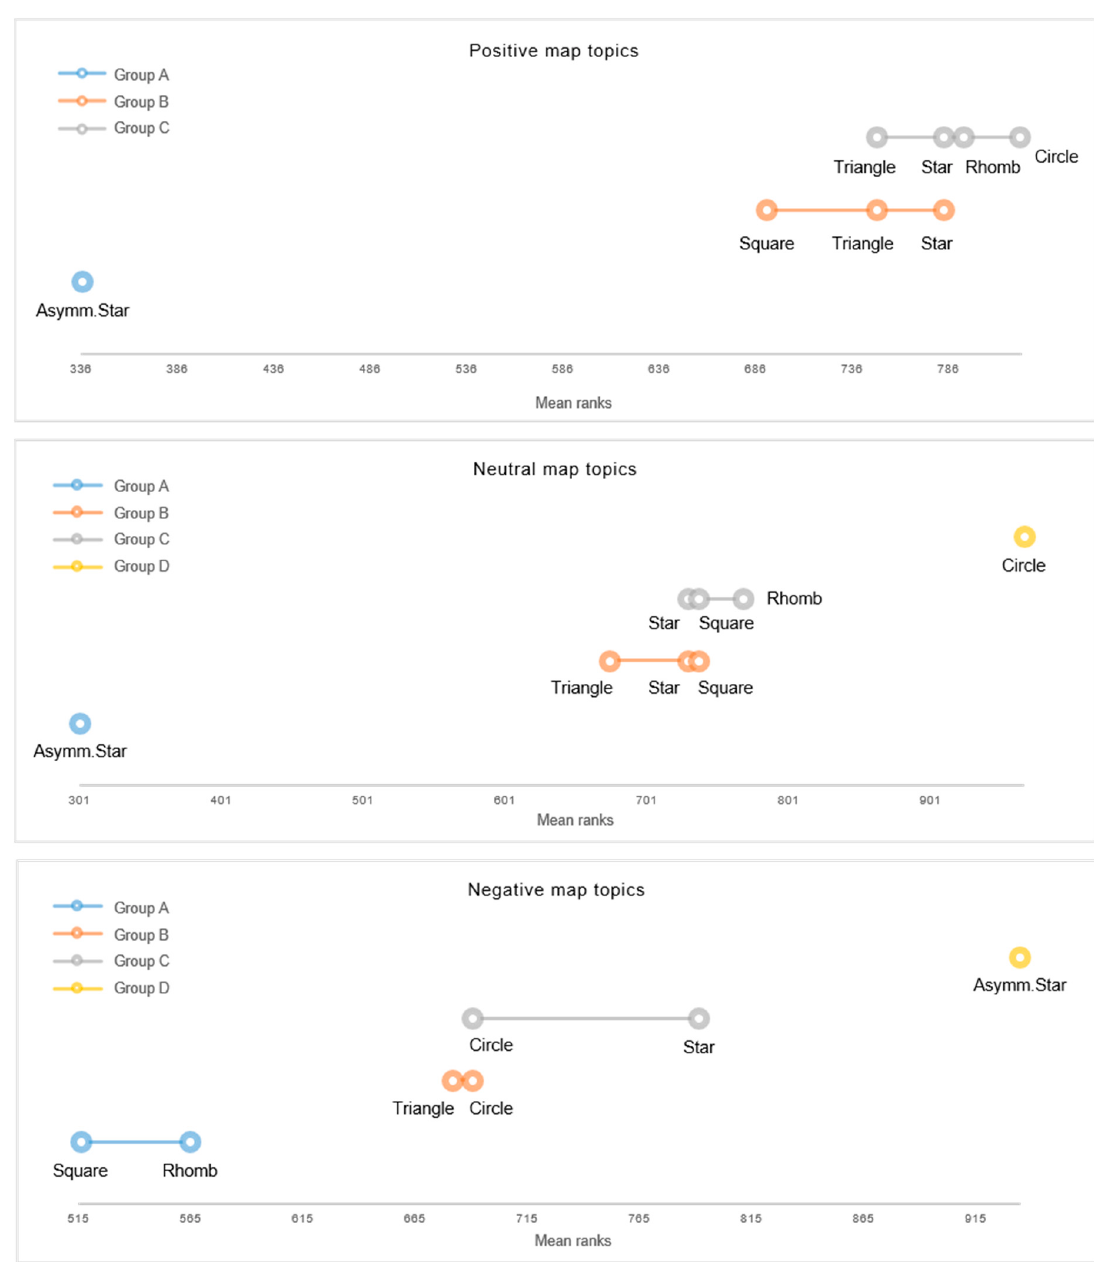
Figure 4. Demšar graphs based on Conover-Iman multiple pairwise comparisons, illustrating the (in)congruence between map symbols when depicting positive, neutral, and negative topics.